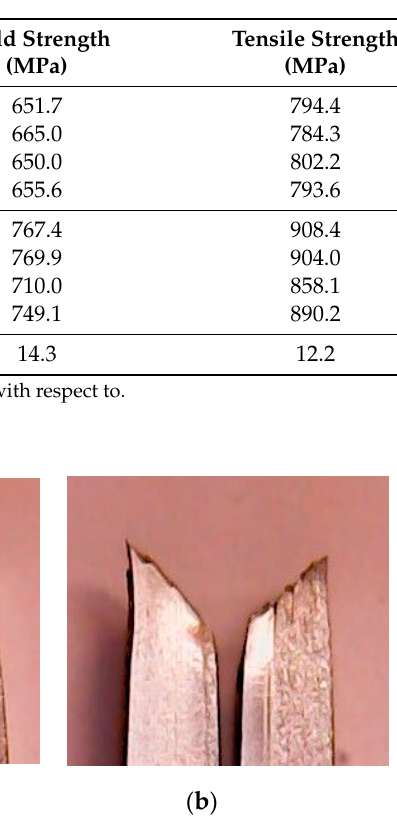
Figure 11. Typical tensile stress-strain curves of BM and friction stir processed (FSPed) 2507 SDSS. Table 3. Tensile behavior of BM and FSPed 2507 SDSS.